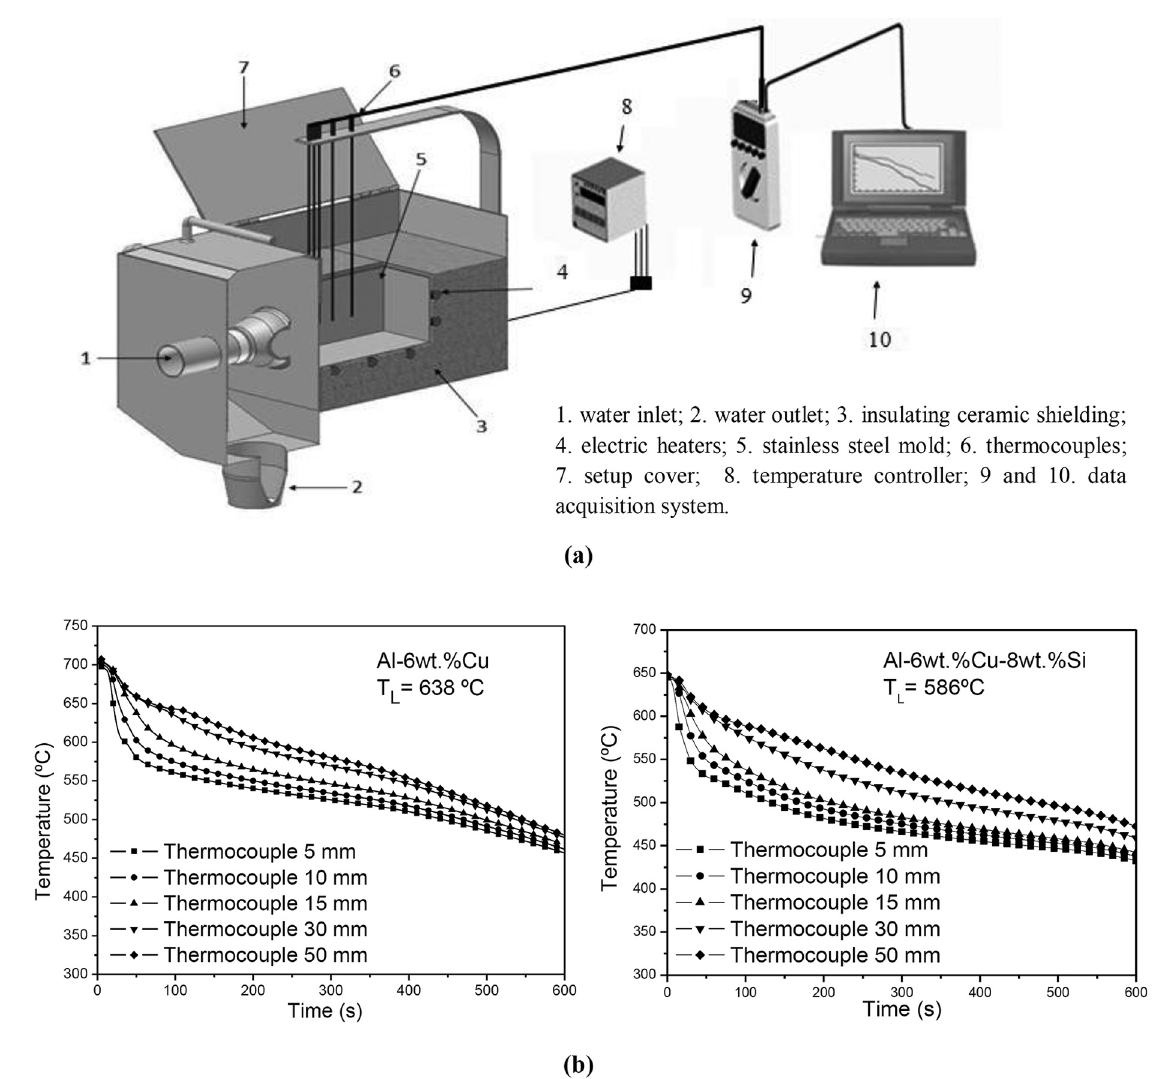
Figure 1 - ( a ) Scheme of the experimental apparatus for horizontal directional solidi fi cation and ( b ) Experimental cooling curves for fi ve thermocouples located at different positions from the metal-cooling chamber